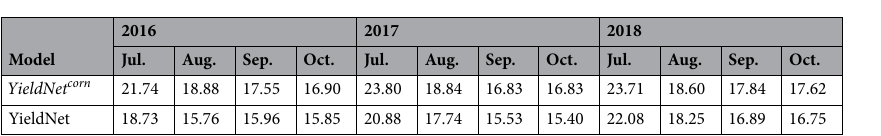
Table 8. The RMSE of the corn yield prediction performances of the YieldNet and YieldNet corn models. The unit of RMSE is bushels per acre.